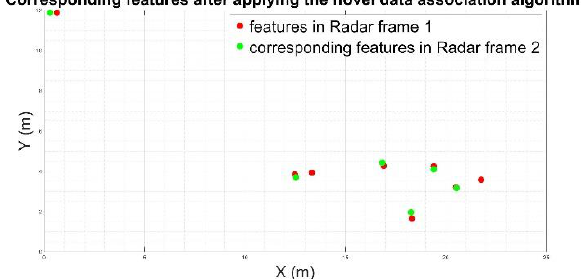
Figure 6. Corresponding features in two successive Radar frames.